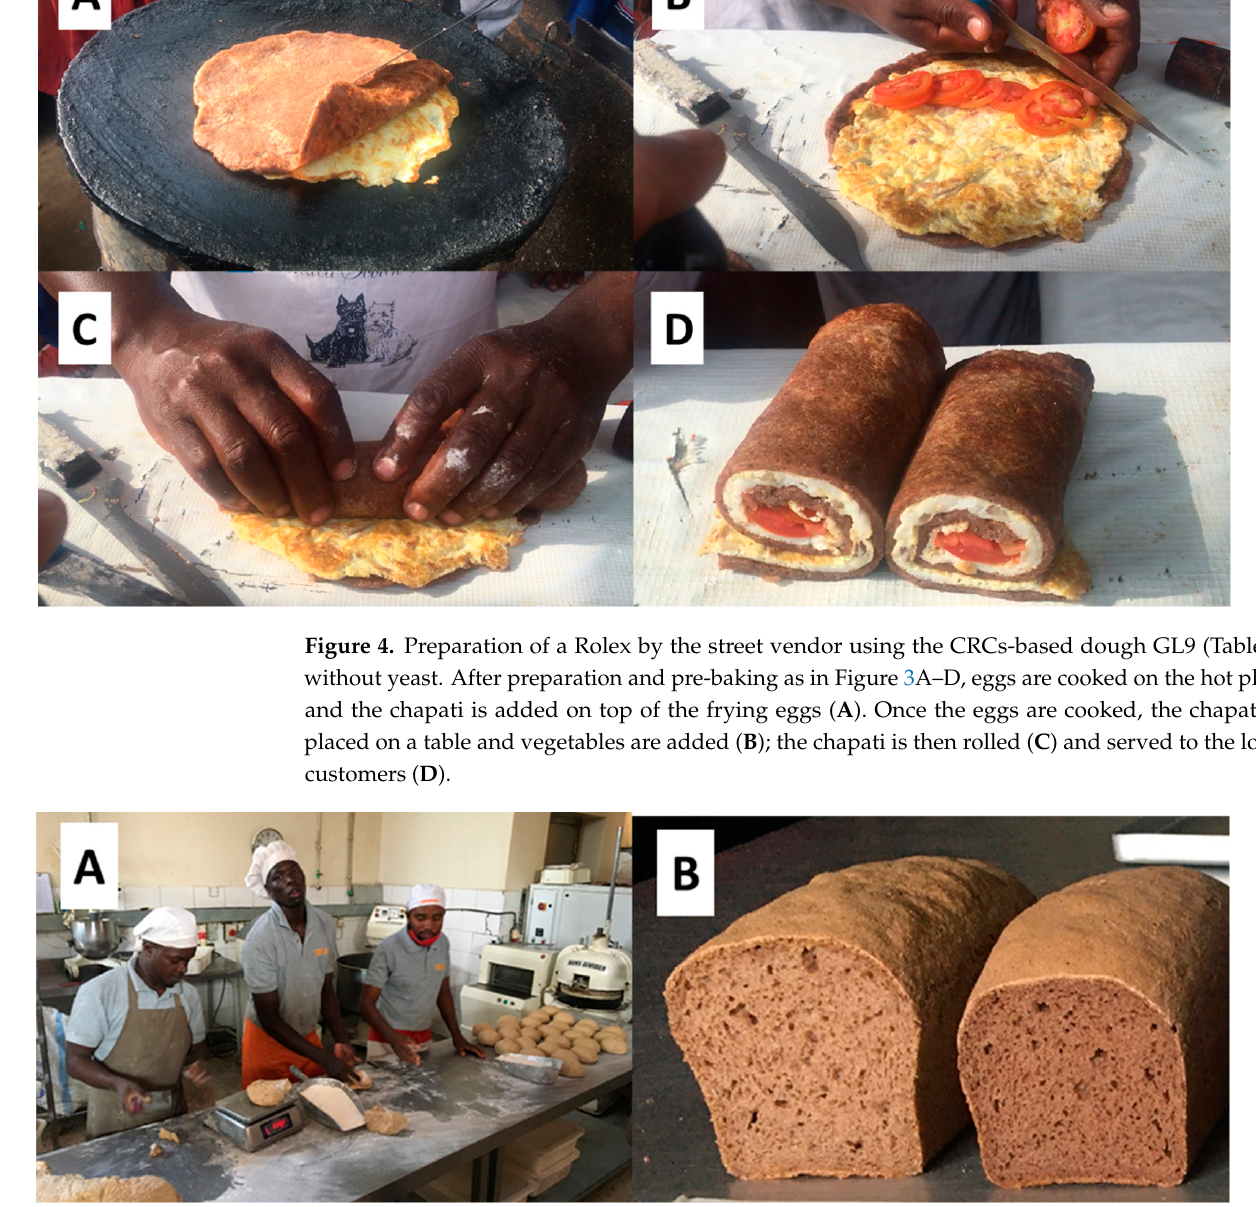
Figure 5. Bakers at BBROOD bakery in Tororo preparing the CRCs-based dough for tin bread baking ( A ); tin breads from the CRCs dough (formulation GL9 in Table 1) based on flours used in this study ( left ) and with flours locally sourced ( right ) ( B ).